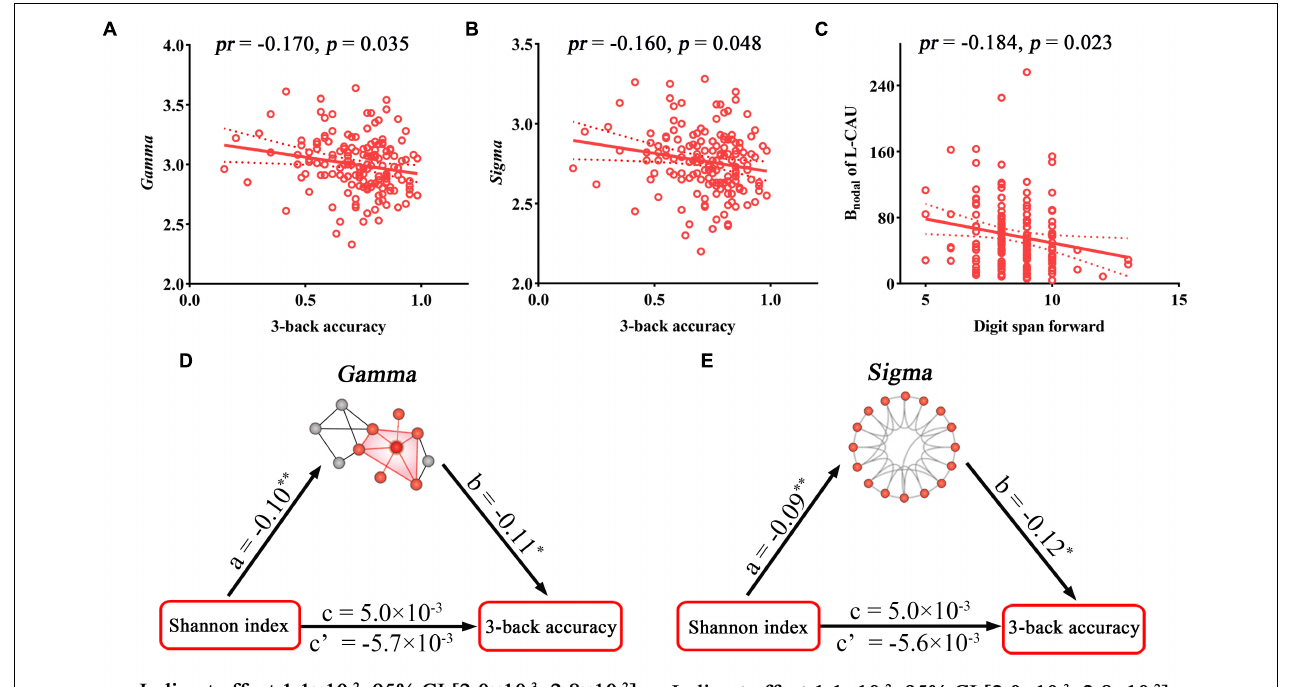
FIGURE 4 | Correlations and mediations between topological properties of SC, gut microbiota, and cognition. (A–C) Scatter plots of the correlations between topological metrics of SC and cognition. (D,E) The mediation analyses between gut microbial diversity (X) and 3-back accuracy (Y), with small-worldness parameters of SC as the mediator (M). Path coefficients with p -values (* p < 0.05 and ** p < 0.01, respectively). B nodal , nodal betweenness; CI, confidence interval; pr , partial correlation coefficient; SC, structural